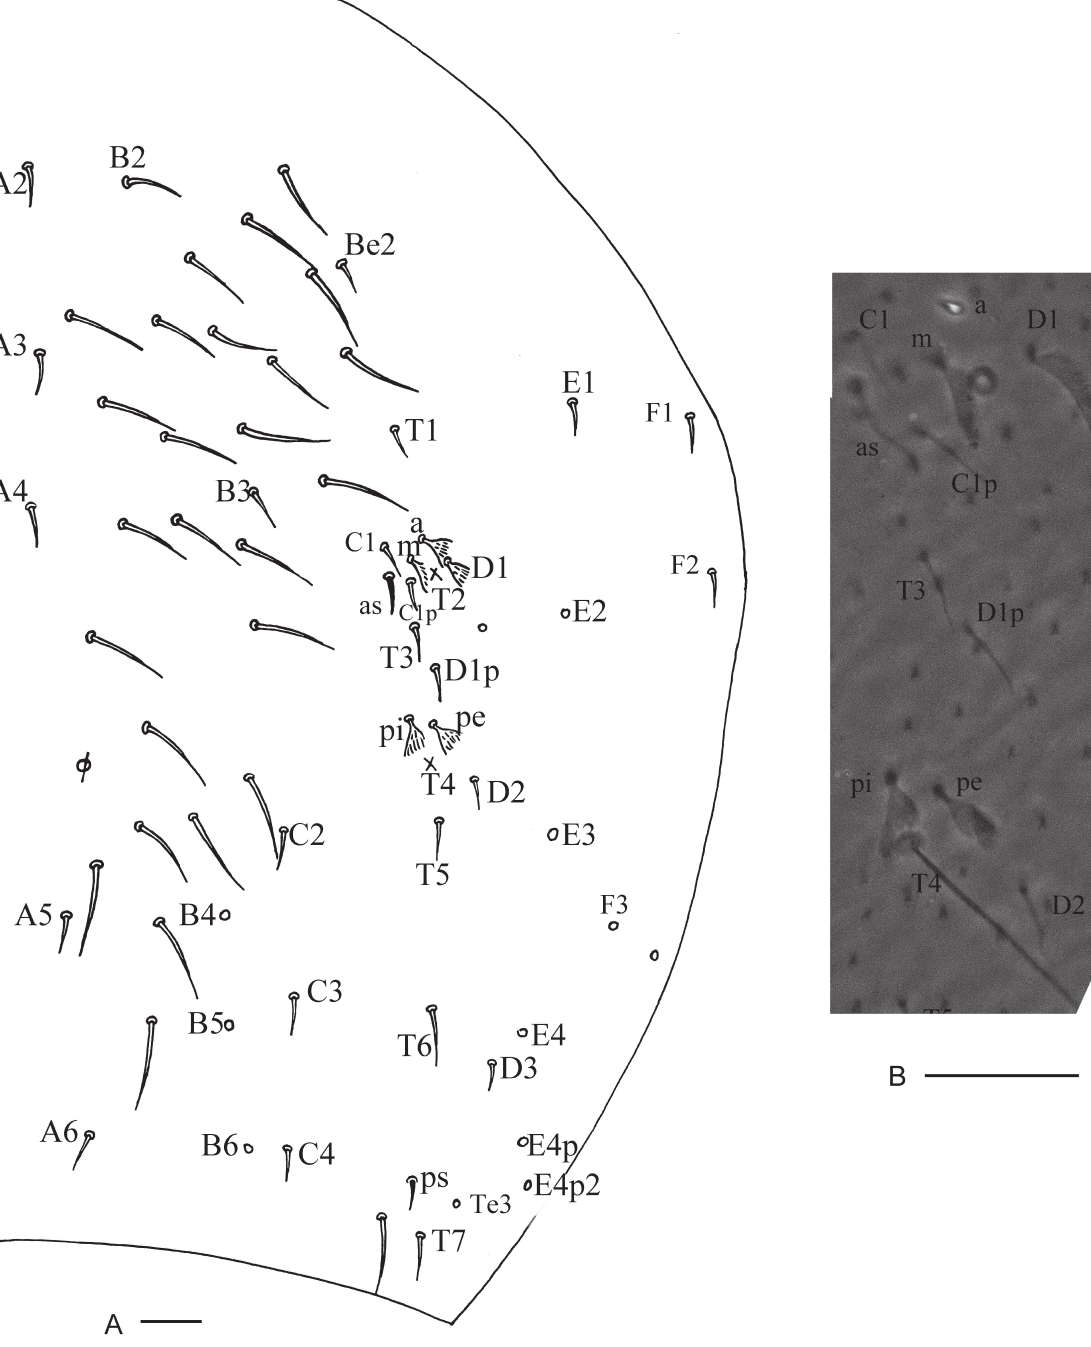
Fig. 7. Lepidocyrtus ( A. ) huizhouensis sp. nov., dorsal chaetotaxy (right side). A . Abd. IV. B . Anterior bothriotrichal complex of Abd. IV. Scale bars: 30